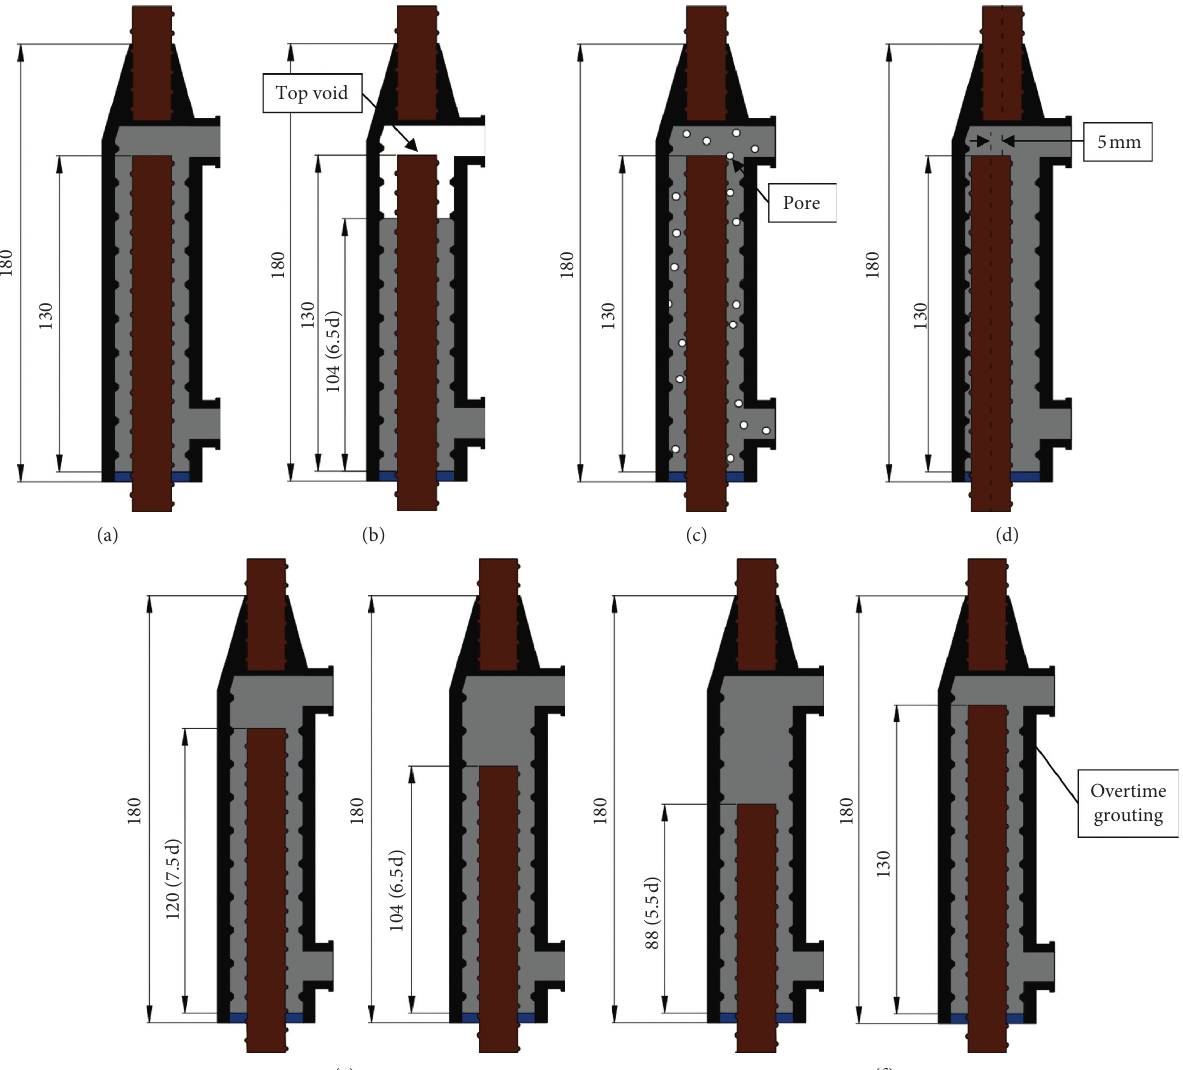
Figure 2: Detailed specimen design sample: (a) control group; (b) insufficient grout height specimen; (c) insufficient compactness specimen; (d) rebar offset specimen; (e) insufficient rebar anchor length specimen; (f) overtime grouting specimen (unit: